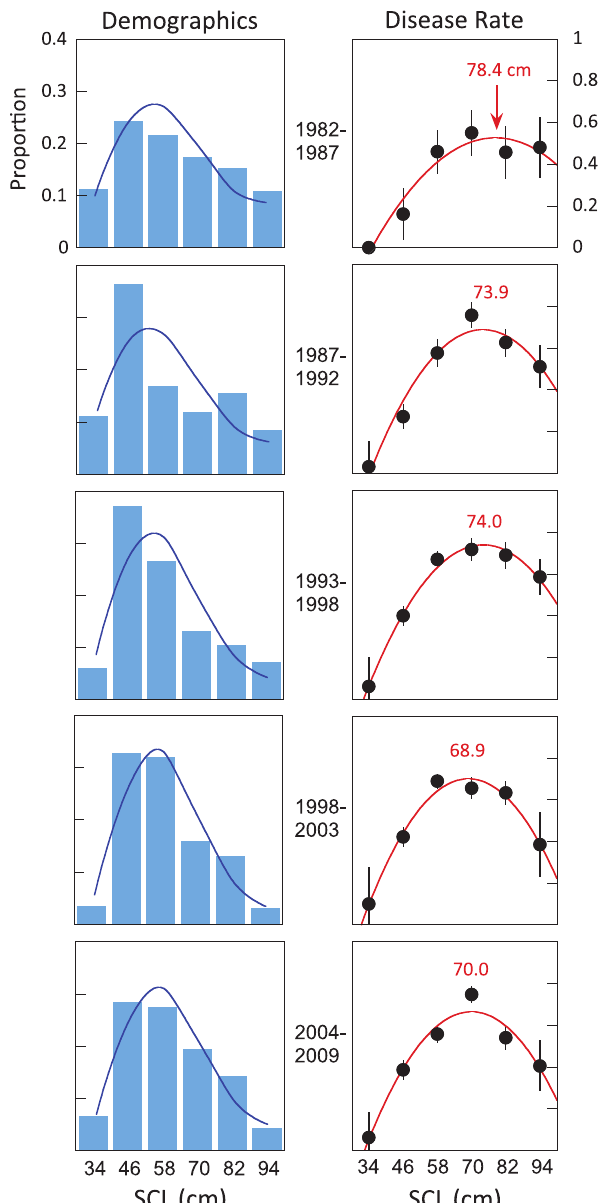
Figure2.Turtle sizeis aconsistent riskfactor throughtime. Theleft panel series plots demographic data of the population during five equal time periods in six size classes ( , 40, 40–51, 52–63, 64–75, 76–87, . 88 cm) plotted as the mean value. The fitted log-normal distribution (blue line) shows a pulse of new individuals into the population (1987–1992) and a subsequentshift toa populationwith more juveniles and subadults (classes 2–4). The right panels show the raw incidence proportions of the disease through time. In four of five time periods, infection rates peak in the fourth size class, corresponding to the time each size class spends in nearshore ecosystems in the main Hawaiian Islands. Red line is the quadratic fit for all periods (bars are s. e.), listed number is the size at peak rate. doi:10.1371/journal.pone.0012900.g002 The GWR examines how Nitrogen-footprint influences disease rates within watersheds; comparing the two map series in Fig. 4. The highest-ranked model used an adaptive bandwidth kernel featuring the influence of , 15 neighbor watersheds (Table S4).